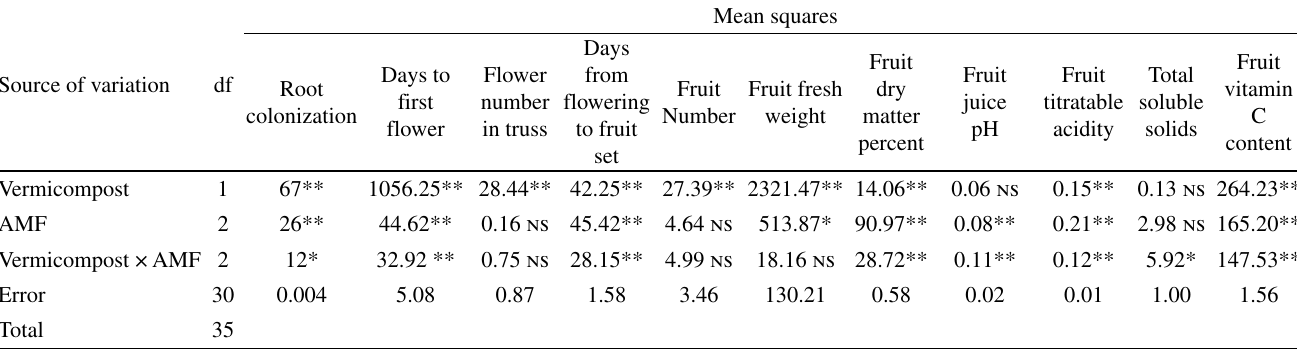
Table 2 - Analyses of variance for vermicompost application and arbuscular mycorrhizal fungi inoculation on some pepino plant characteristics